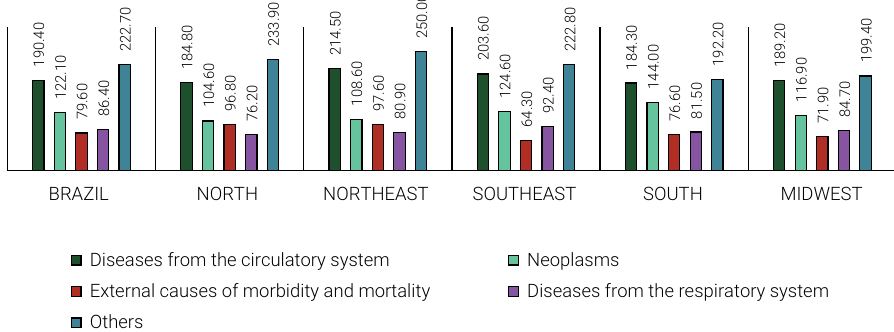
Figure 1. ASMR’s in Brazil and its geographic regions according to ICD - 10 chapters.